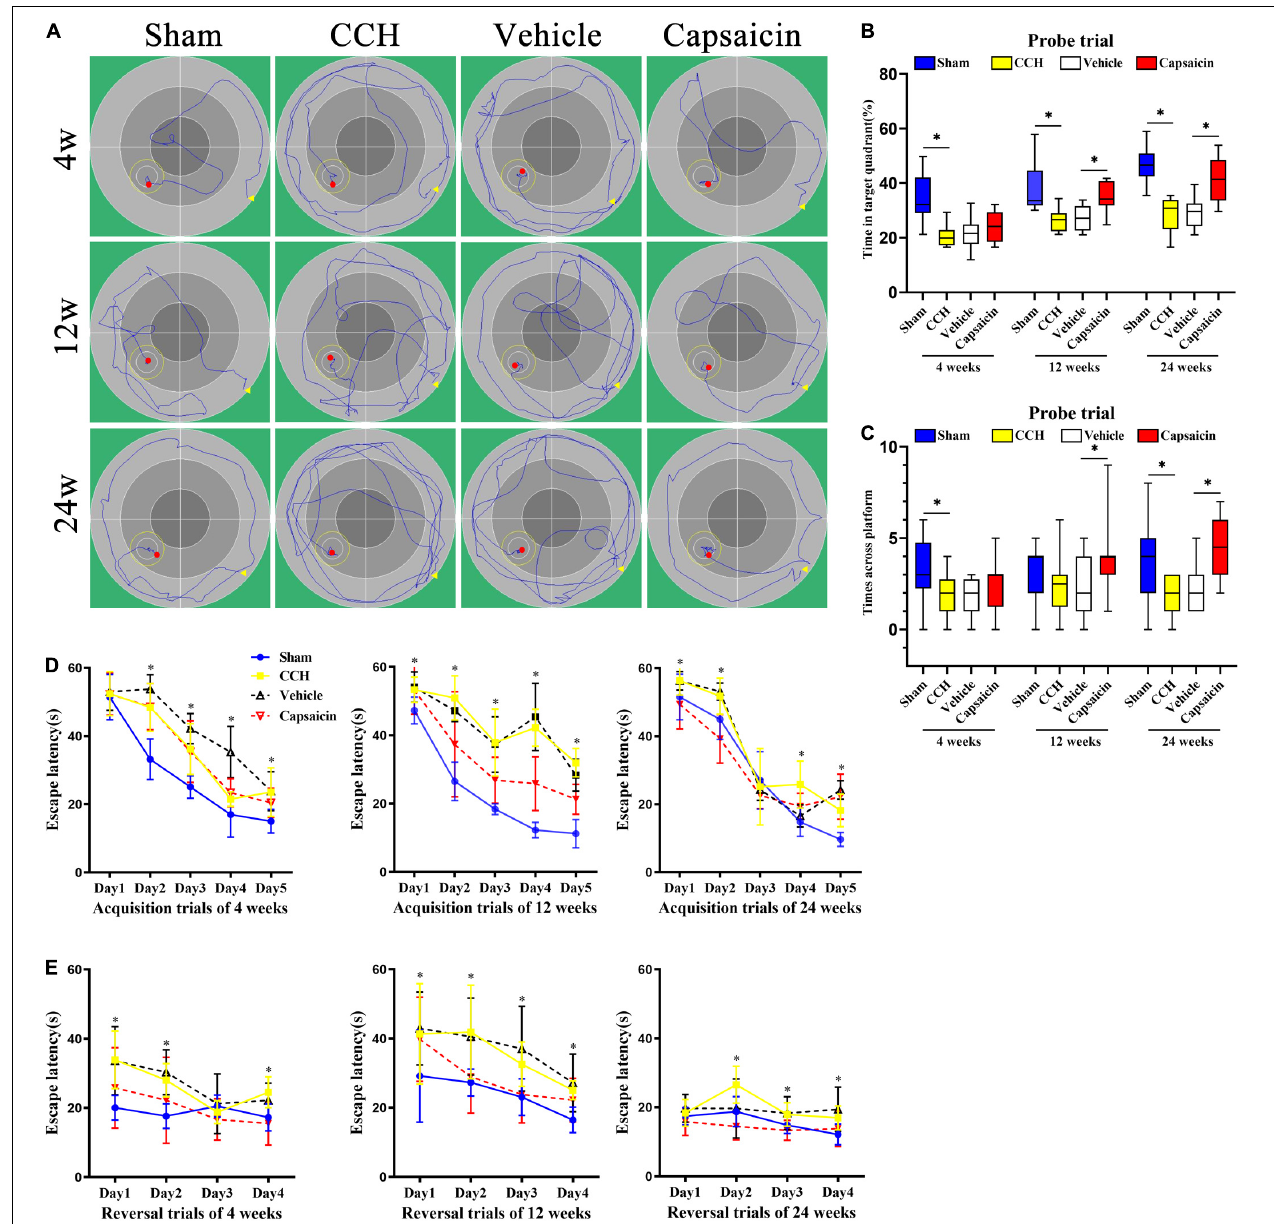
FIGURE 4 | Capsaicin reverses CCH-induced spatial learning and memory impairments in the MWM. (A) Representative activity traces of the MWM ( n = 12 rats/group). (B) Spatial reference memory was analyzed using the probe trial, boxplot showing the percentage of time spent in the platform quadrant. (C) The number times rats crossed the original platform location. (D) Spatial learning was assessed by acquisition trials of the MWM. CCH rats (yellow squares), sham-operated rats (blue circles), capsaicin-treated rats (red inverted triangles) and vehicle-control rats (black triangles) were tested at 4, 12, and 24 weeks after BCCAO. Escape latency to the hidden platform during acquisition trials of the MWM at (left panel) 4 weeks, (middle panel) 12 weeks, and (right panel) 24 weeks. (E) Spatial working memory was impaired in CCH rats during reversal trials at (left panel) 4 weeks, (middle panel) 12 weeks, and (right panel) 24 weeks, and capsaicin-treated rats had significantly shorter escape latencies than vehicle control rats at (left panel) 4 weeks, (middle panel) 12 weeks and (right panel) 24 weeks. Data are presented as the mean ± SD. * P < 0.05. Data were analyzed by two-way ANOVA followed by the post hoc LSD test, and unpaired t -tests were used to analyze probe trials’ number of crossings the platform and time spent in target quadrant.